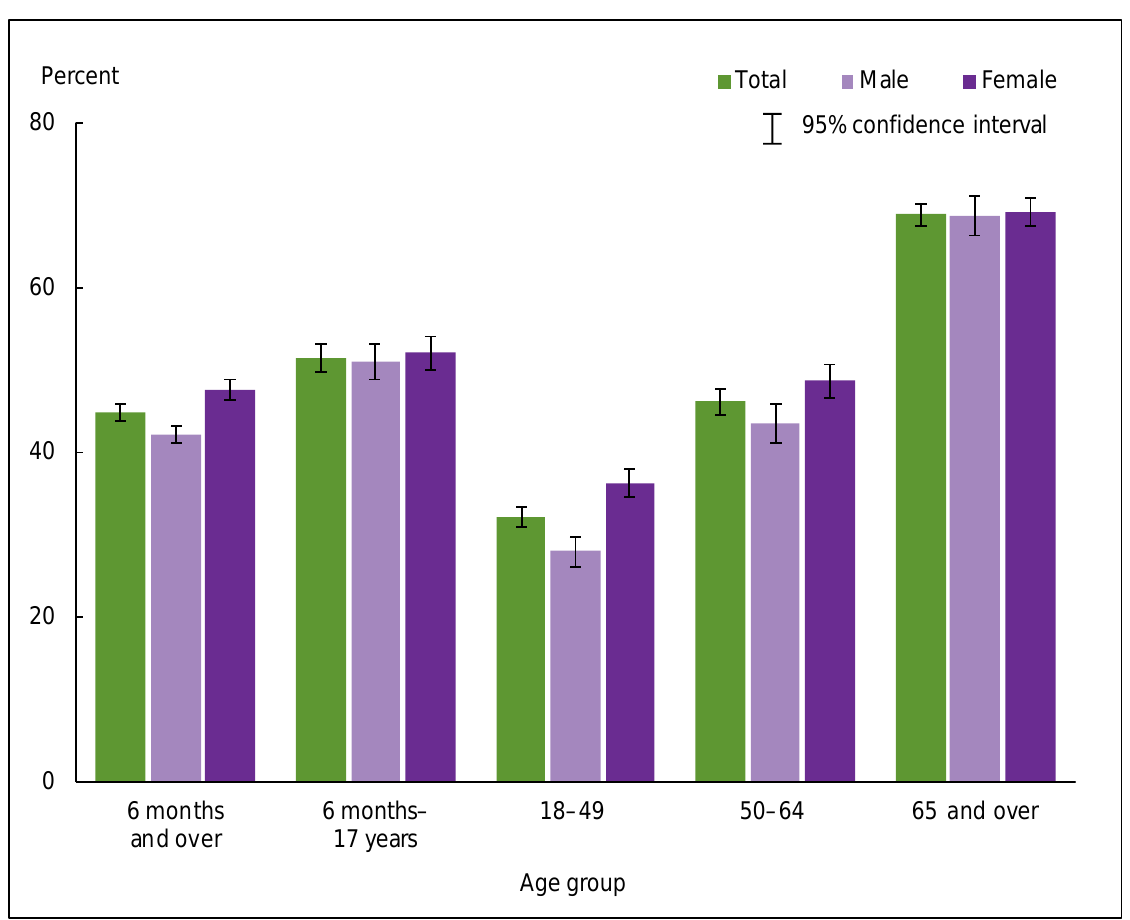
Figure 4.2. Percentage of persons who received an influenza vaccination during the past 12 months, by age group and sex: United States,